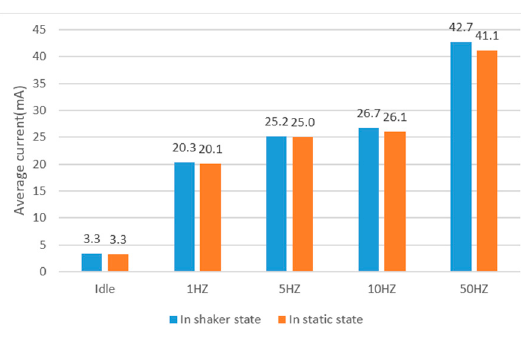
Figure 12. The average currents of the ARS at different sampling rates.